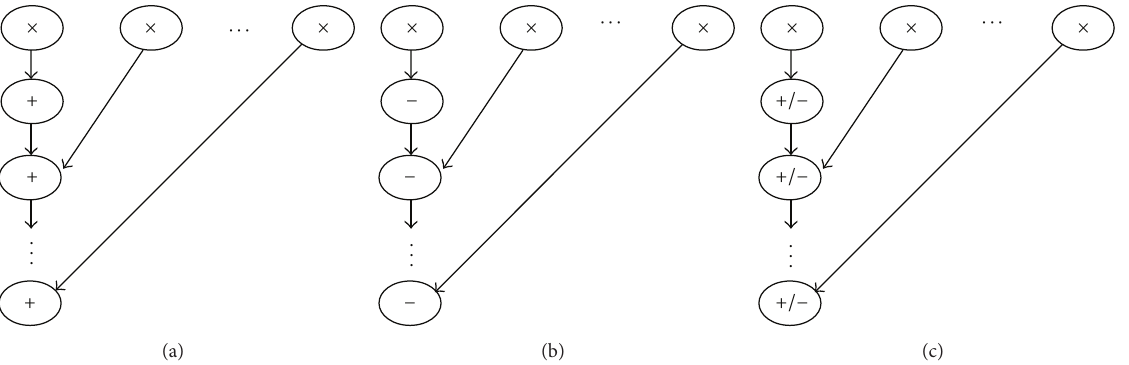
Figure 1: (a) Chain of multiply-add, (b) chain of multiply-subtract, and (c) chain of multiply with a mix of add and subtract.